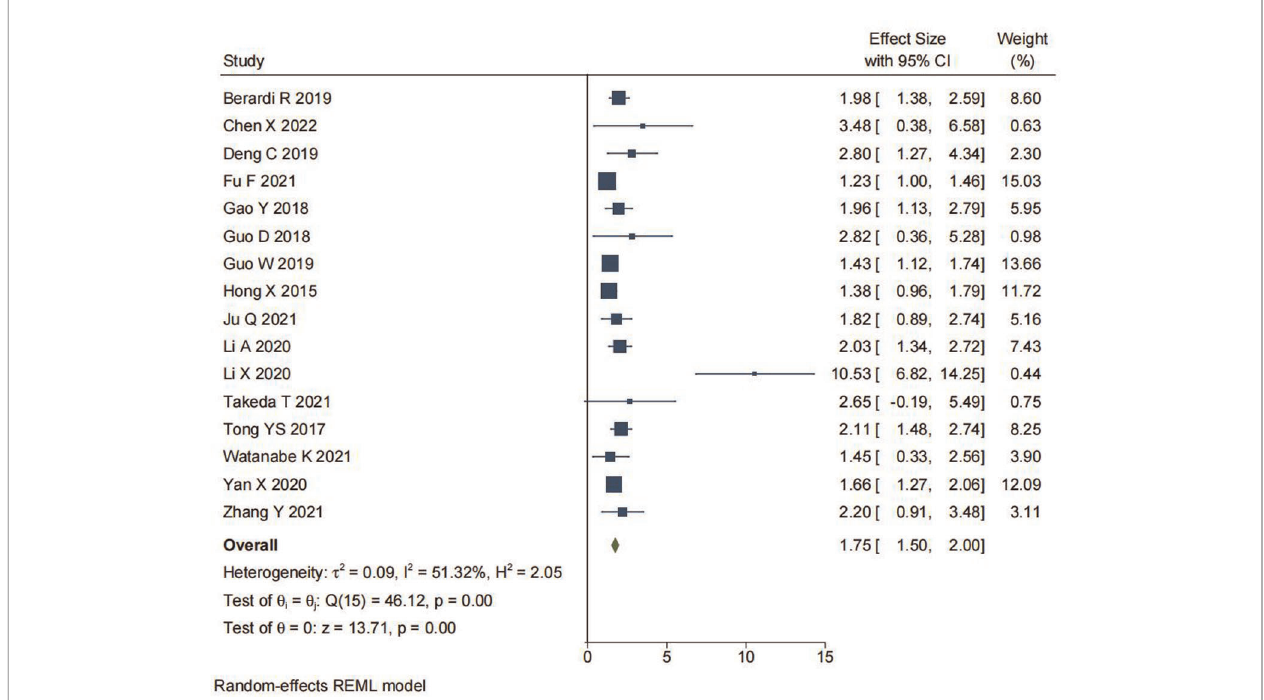
FIGURE 2 | Forest plot depicting the relationship between SII levels and OS in NSCLC.